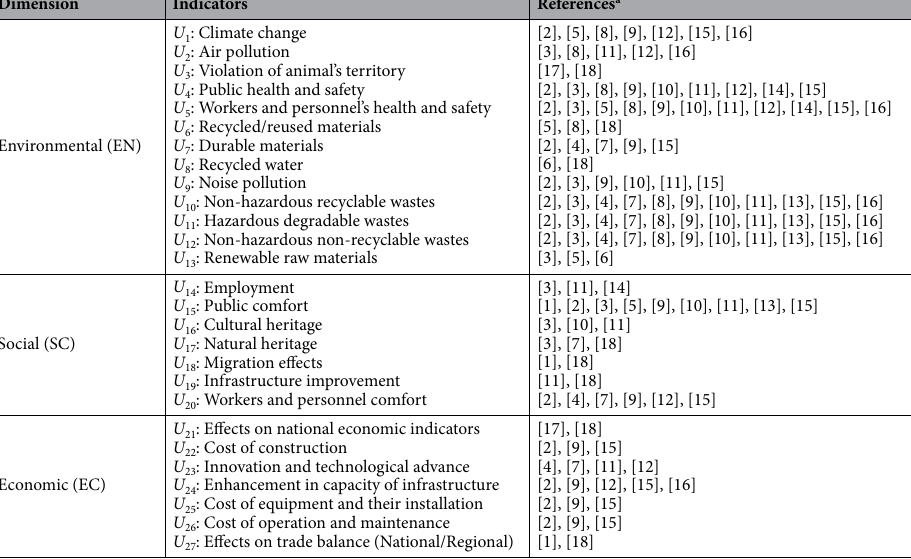
Table 1. Evaluation and identification of sustainable development indicators (SDIs). a [1] Domac et al., 2005 68 ;